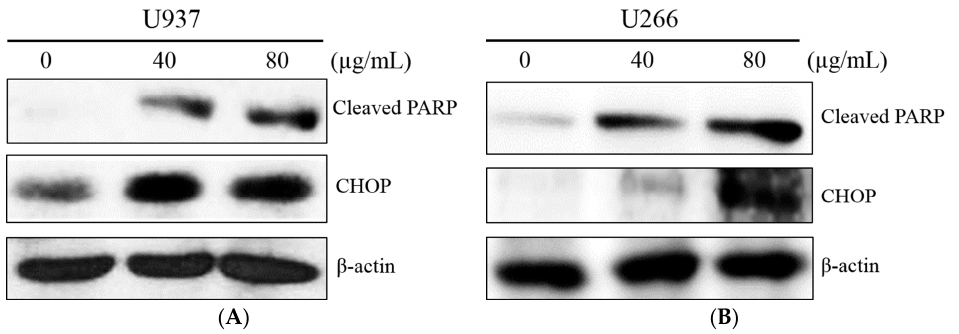
Figure 3. The effect of COM on ER stress-mediated apoptosis-related proteins in U937 and U266 cells. ( A ) U937 cells were treated with COM (40 or 80 µg/mL) for 24 h, and Western blot analysis was performed for cleaved PARP, CHOP, and β -actin; ( B ) U266 cells treated under the same conditions, Western blot analysis.